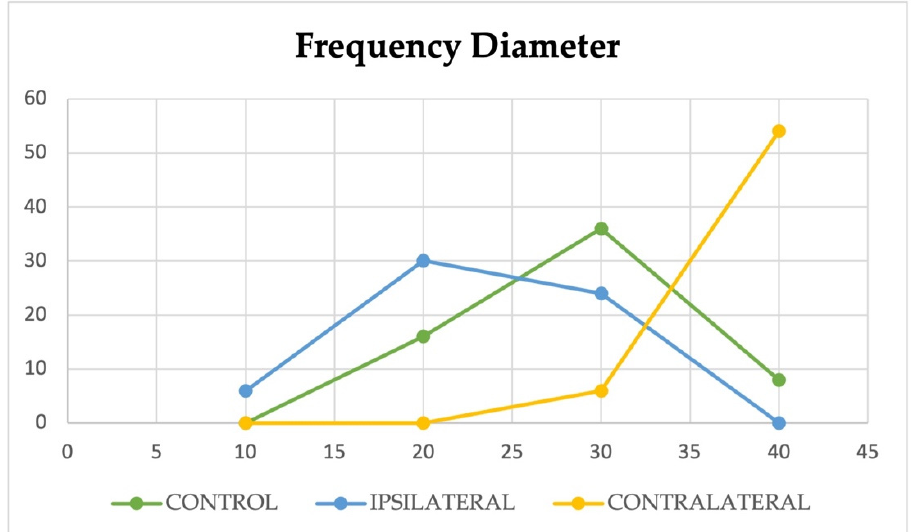
Figure 4. The graphic shows the frequency of diameter values. The y-axis shows the number of fibers and the x-axis shows the ranges of diameter values expressed in μ m. Most of the fiber and the x-axis shows the ranges of diameter values expressed in µ m. Most of the fiber diameters diameters are between 20 and 30 μ m for the control group, between 10 and 20 μ m for the ipsilateral are between 20 and 30 µ m for the control group, between 10 and 20 µ m for the ipsilateral muscle muscle (crossbite group) and between 30 and 40 μ m for the contralateral muscle (crossbite group). (crossbite group) and between 30 and 40 µ m for the contralateral muscle (crossbite group). The frequency data of cross-sectional area values show that most of the cross- The frequency data of cross-sectional area values show that most of the cross-sectional sectional area values are between 300 and 400 μ m 2 for the control group, between 200 and area values are between 300 and 400 µ m 2 for the control group, between 200 and 300 µ m 2 300 μ m 2 for the ipsilateral muscle (crossbite group) and between 700 and 800 μ m 2 for the for the ipsilateral muscle (crossbite group) and between 700 and 800 µ m 2 for the contralat- contralateral muscle (crossbite group) (Figure 5). eral muscle (crossbite group) (Figure 5).